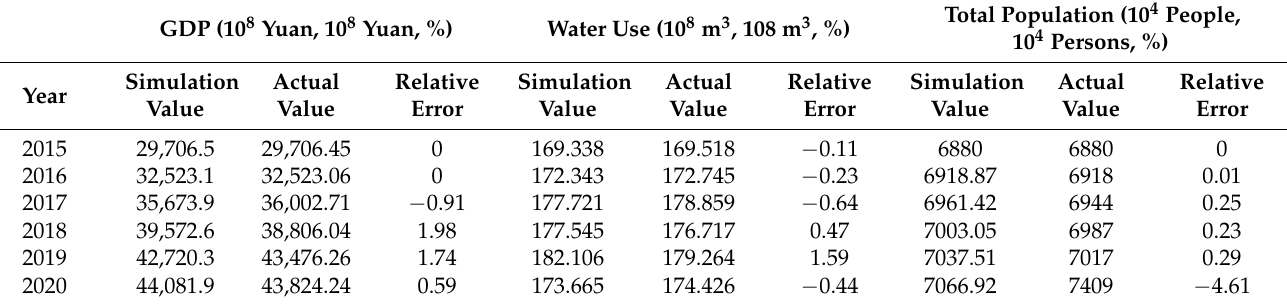
Table 4. The test results of the model.